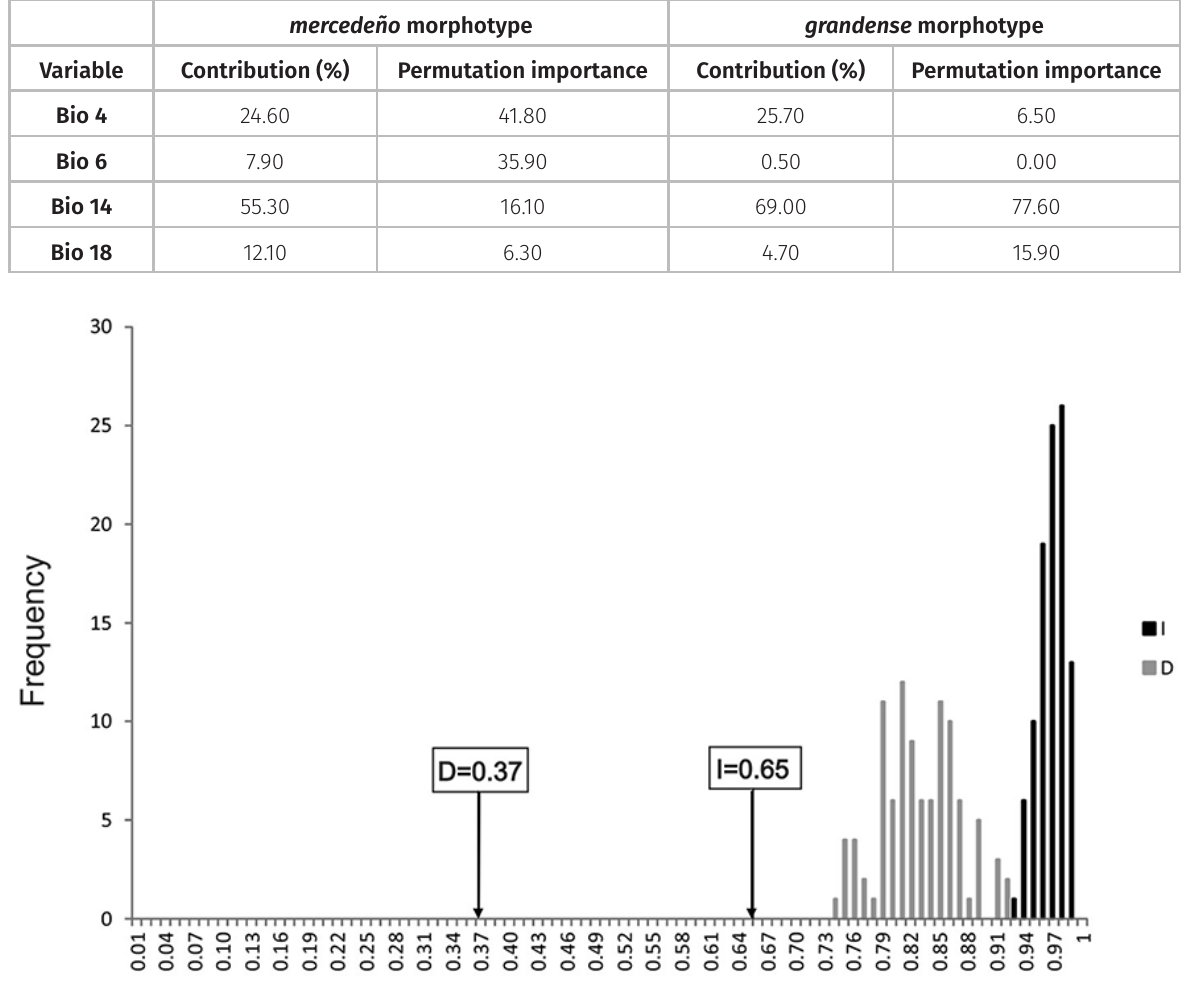
Figure 4. Niche overlap evaluated by the identity test. Arrows refer to the actual niche overlap (D and I) as calculated by ENMTools. The dark and light gray columns are calculated by replicates with identity test